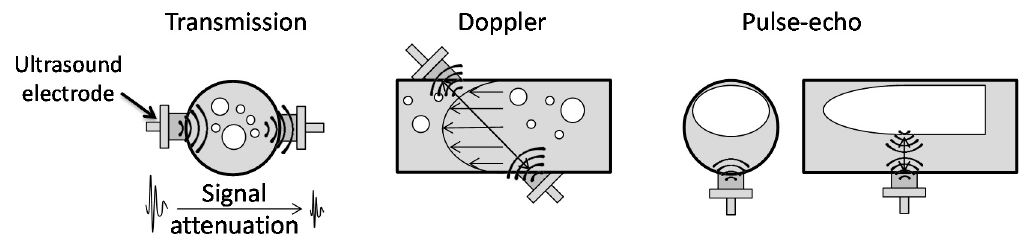
Figure 6. Illustration of ultrasound principle for transmission, Doppler and pulse-echo